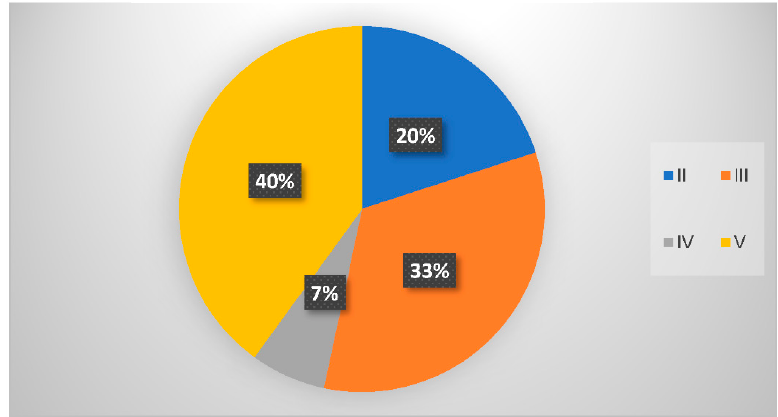
Figure 11. Percentage share of decision models in the research